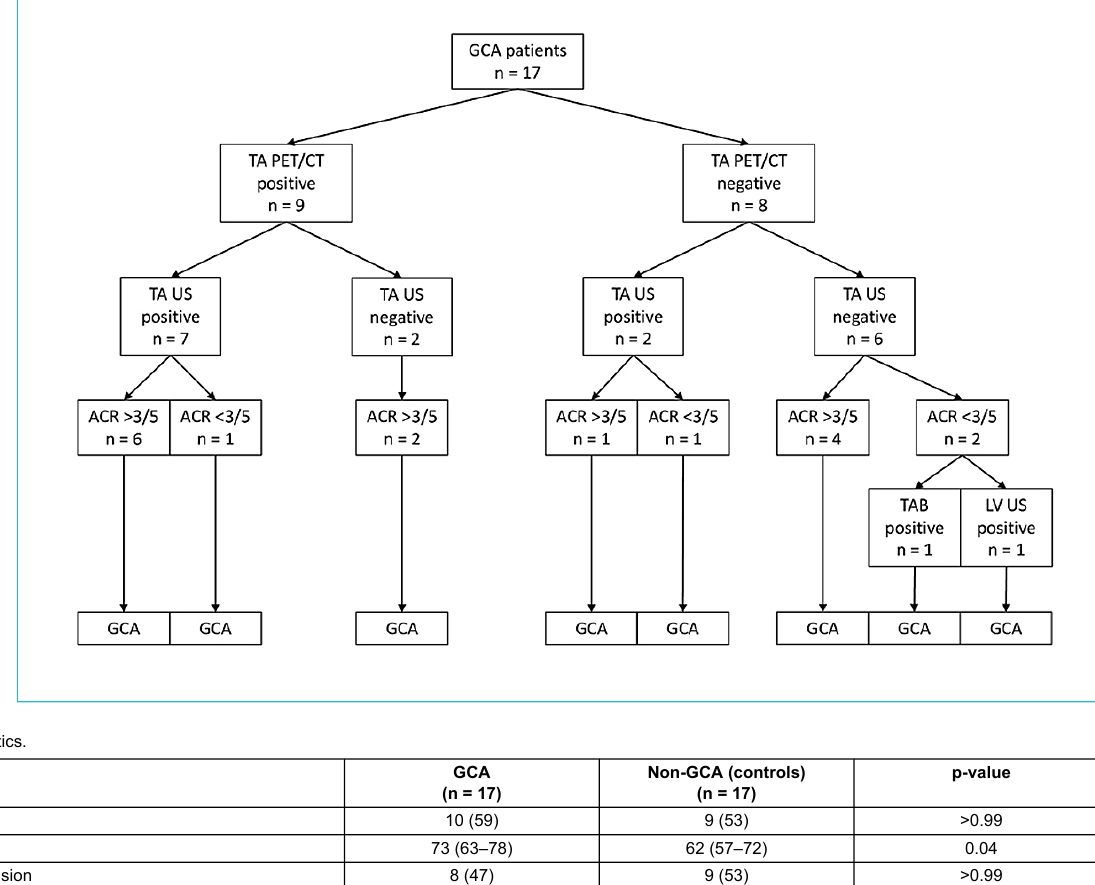
Figure 1: Diagnostic findings in GCA patients.ACR = American College of Rheumatology criteria for GCA; GCA = giant cell arteritis; LV US = large vessel ultrasound; TAB = temporal artery biopsy; TA PET/CT = temporal artery positron emission tomography-computed tomography; TA